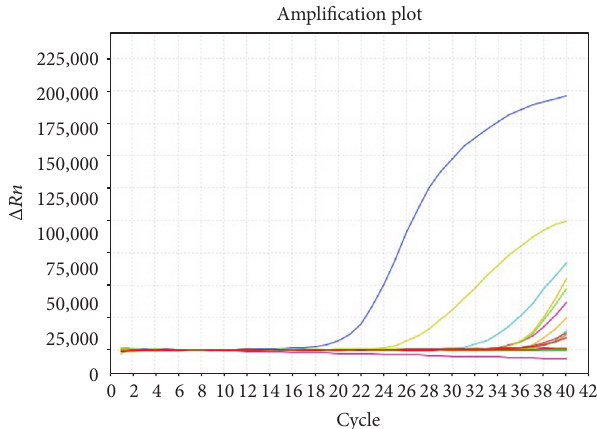
Figure 8: Direct testing of meat samples using TaqMan PCR